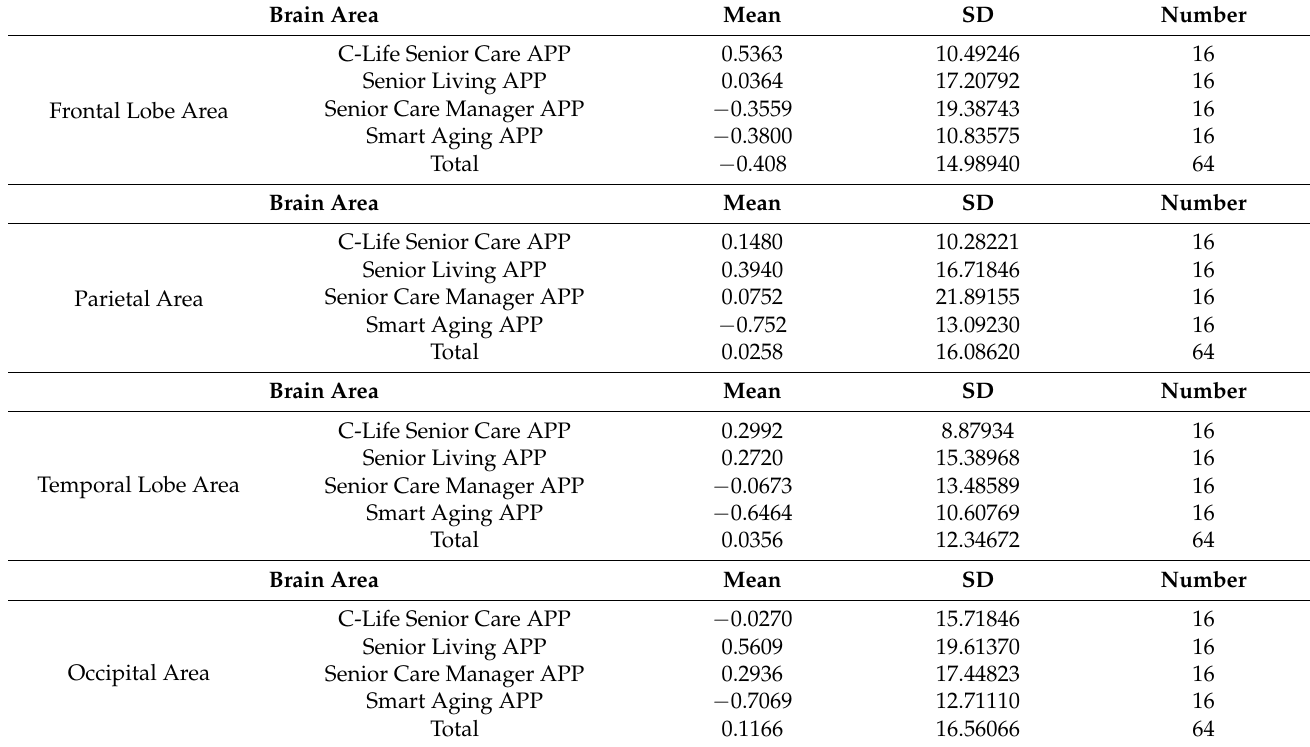
Table 9. Analysis of the mean amplitude of each brain